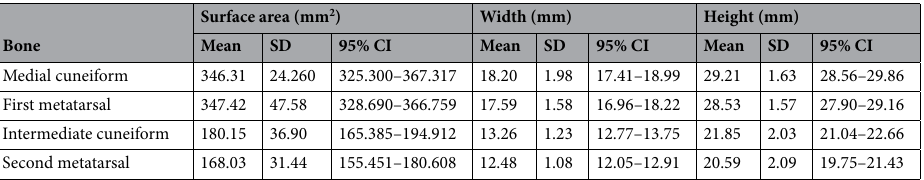
Table 1. Surface area and extrema distance measurements for the articular surfaces of each of the four bones in the first and second TMT joints giving mean, standard deviation, and 95% confidence intervals. Width refers to medial–lateral maximum distance and height refers to dorsal-plantar maximum